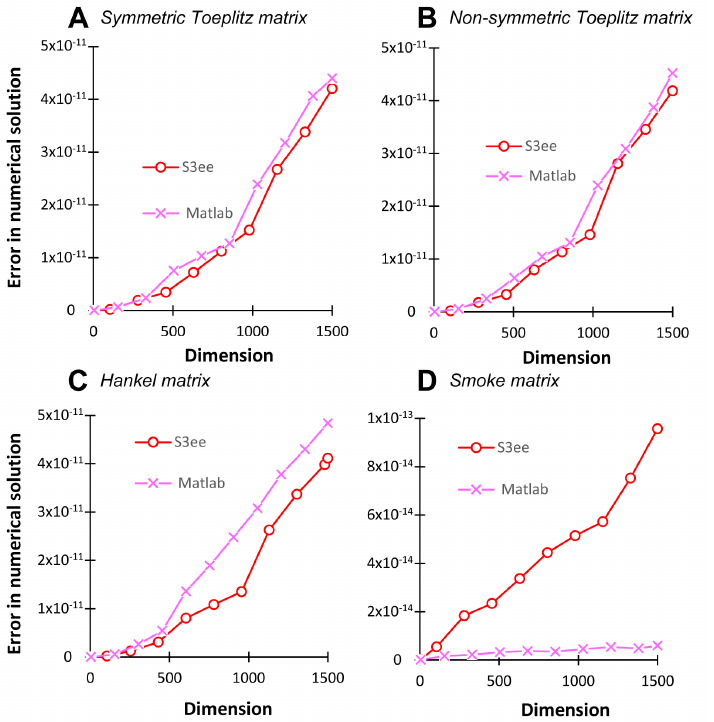
Figure 7. Comparative analysis of the computational accuracy of the ABS-based S3ee algorithm and the Matlab mldivide algorithm on selected Matlab gallery